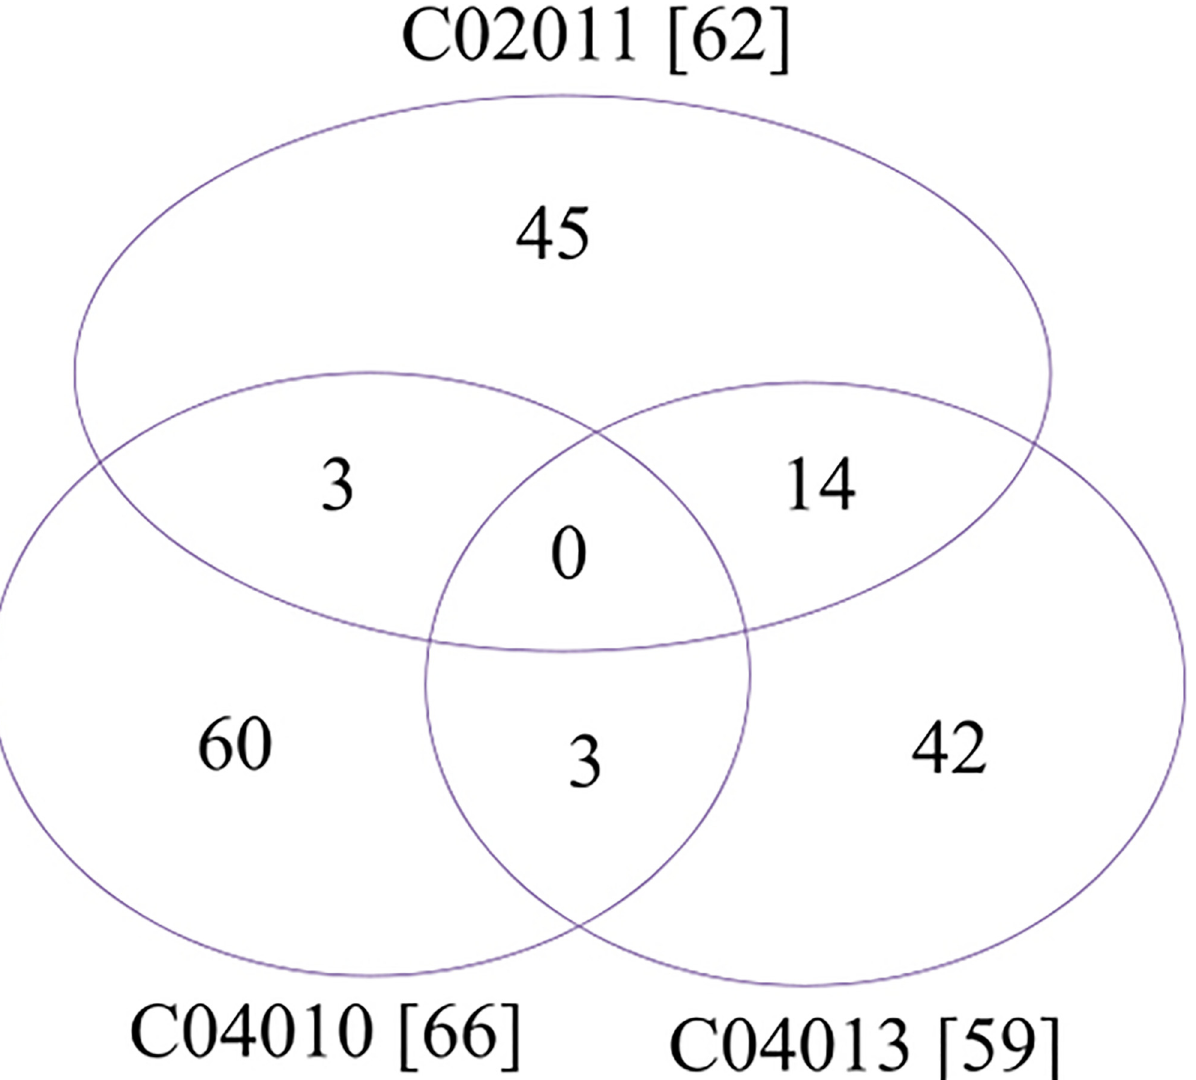
Fig 3. Venn plot of the strain specific genes in the three P . mirabilis DTT strains. The numbers in the brackets are the numbers of DTT specific genes compared against the other P . mirabilis